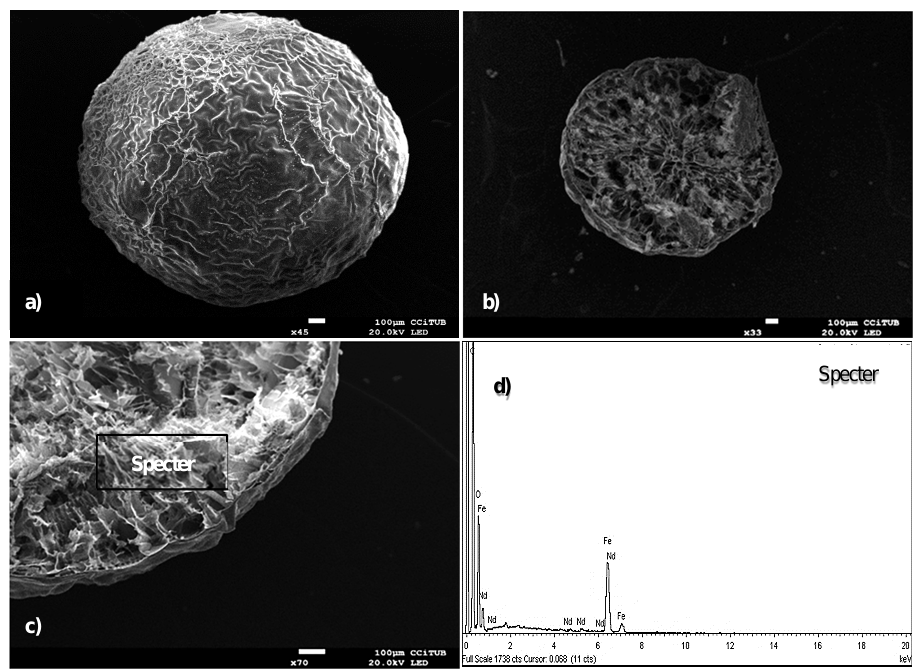
Figure 1. Scanning electron microscopy (SEM) images of the freeze dried (FD) sorbent. ( a ) External surface. ( b ) Cross-section area. ( c , d ) Energy dispersive X-ray (EDX) analysis of the cross-section area of the beads.